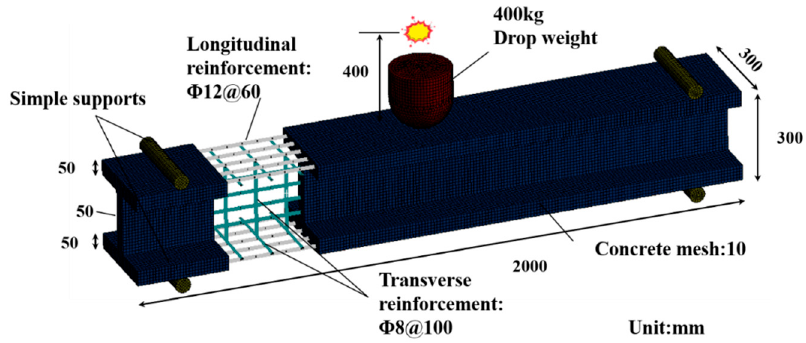
Figure 5. Numerical analysis model of I-shaped RC beam under combined load.